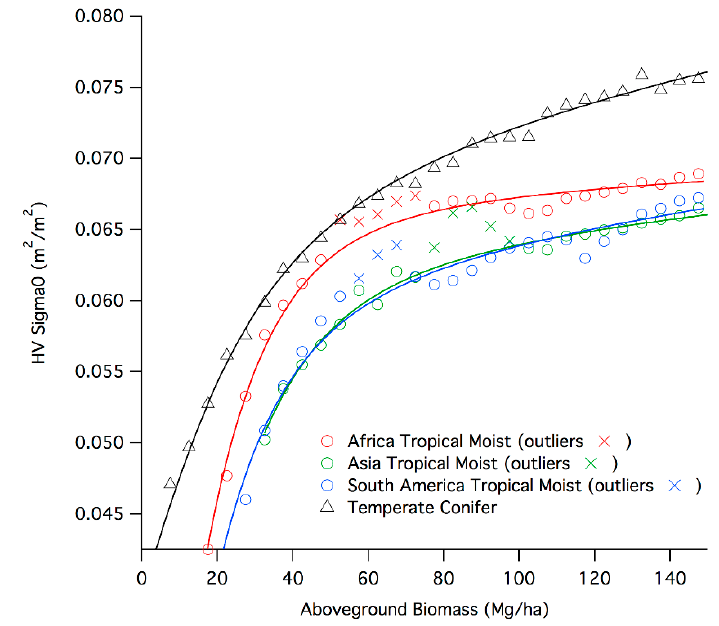
Figure 3. Correlation between bin-averaged ALOS HV sigma-0 means and AGB values of the middle of the bin for the tropical moist forests of Africa, Southeast Asia, and Latin America, as well as temperature conifer forests. Solid lines represent the empirically fitted function of the form defined in Equation (2). Certain outliers were removed before fitting for the tropical moist forest (marked with x). Bins for tropical forests are cut off above 155 Mg·ha − 1 for the purpose of fitting.